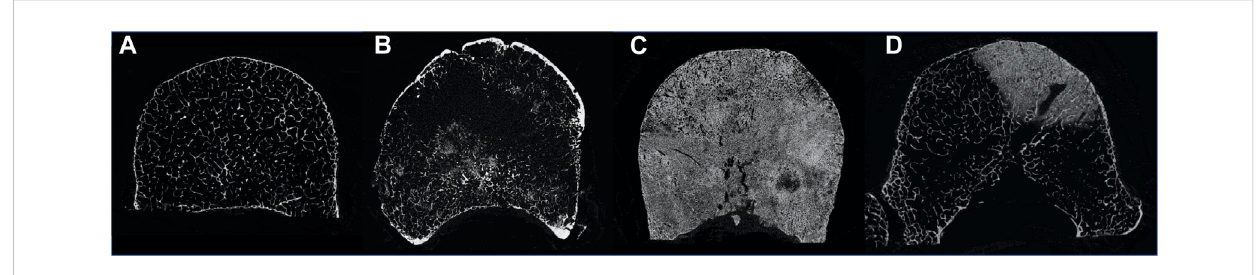
FIGURE 1 MicroCT cross section of a healthy vertebra (A) , a vertebra with lytic metastases (B) , a vertebra with blastic metastases (C) and a vertebra with mixed metastases (D)